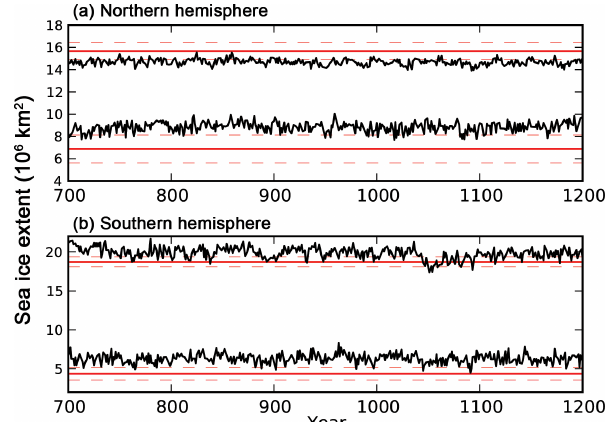
Fig. 4. Time series of (a) northern and (b) southern hemispheric sea-ice extent (10 6 km 2 ) for March and September in piControl. Black lines show simulated, annual mean time series and red lines show observed, annual mean and ± 2std for the years 1979–2005 (data from NSIDC, Fetterer et al., 2009).